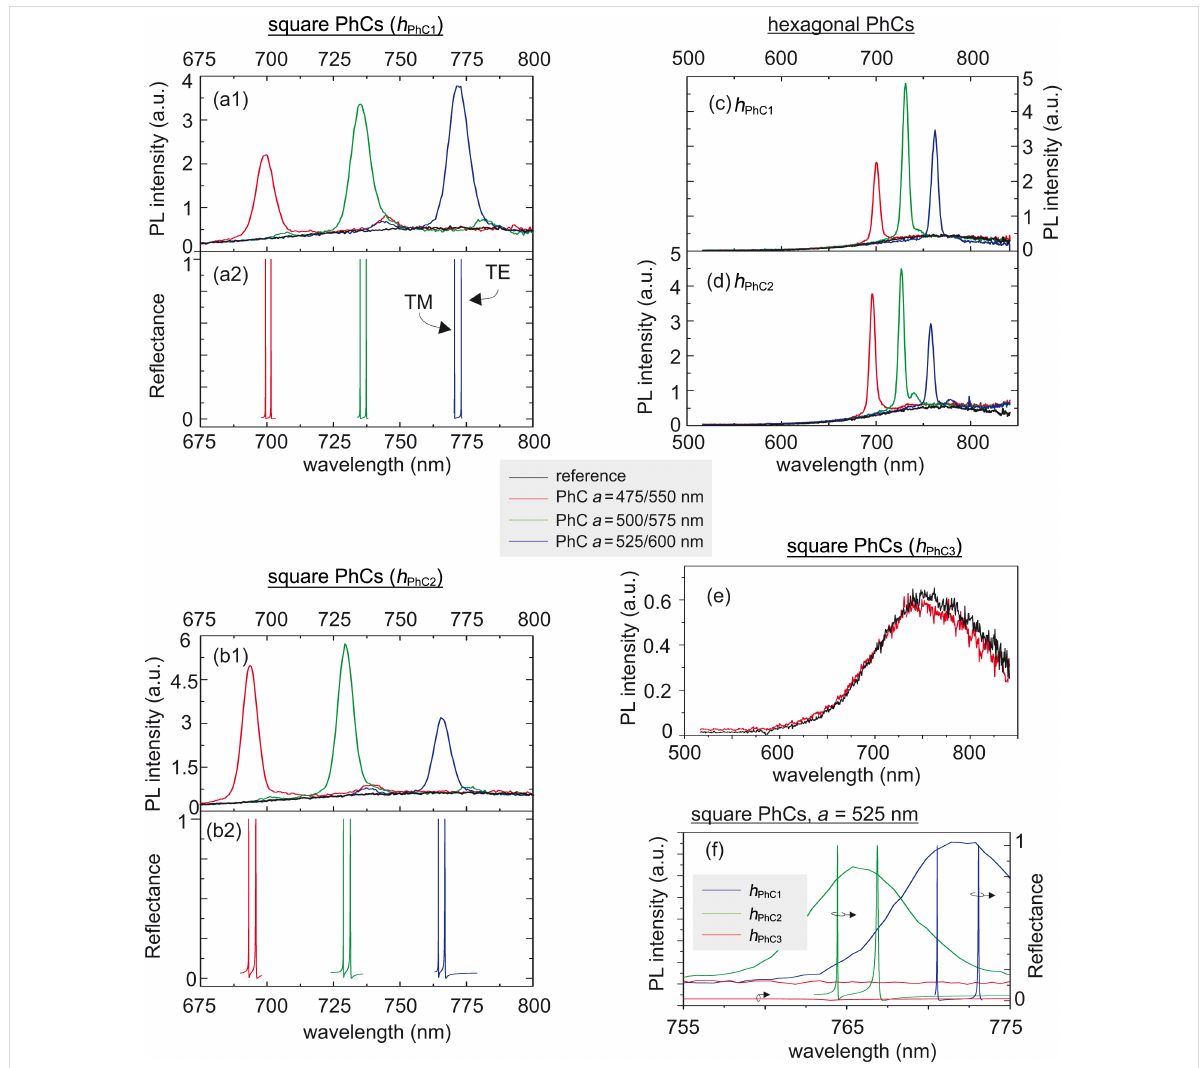
Figure 2: PL spectra of the PhC samples detected with an optical fiber in the direction normal to the sample plane and computed normal reflectance, which reveals the Γ -point leaky modes. The black curves represent the PL spectra of the planar reference. (a1,b1) Measured PL and (a2,b2) simu- lated reflectance of the square PhC with columns height of (a) h PhC1 and (b) h PhC2 , respectively. (c, d) PL of the hexagonal PhC with columns height of h PhC1 and h PhC2 , respectively. (e) PL of the square-lattice PhC with column height h PhC3 (red) compared to the reference (black). In panels (a–e), we use a simple self-explanatory color code in order to distinguish between the PhCs with different lattice constants. (f) PL and computed reflectance of the square-lattice PhCs with lattice constant a = 525 nm and column heights h PhC1 (blue), h PhC2 (green) and h PhC3